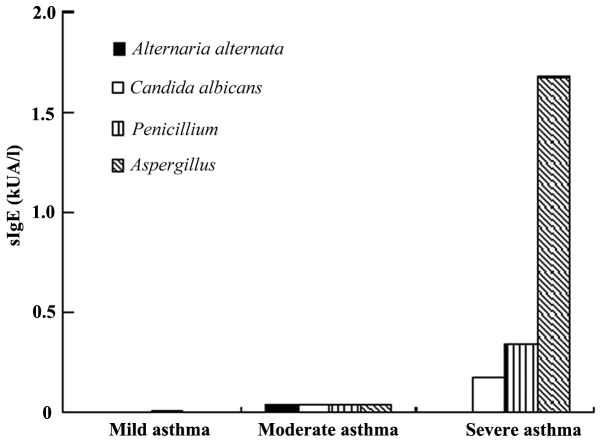
sIgE of fungi sensitinogen in the three asthma groups. sIgE, specific immunoglobulin E.